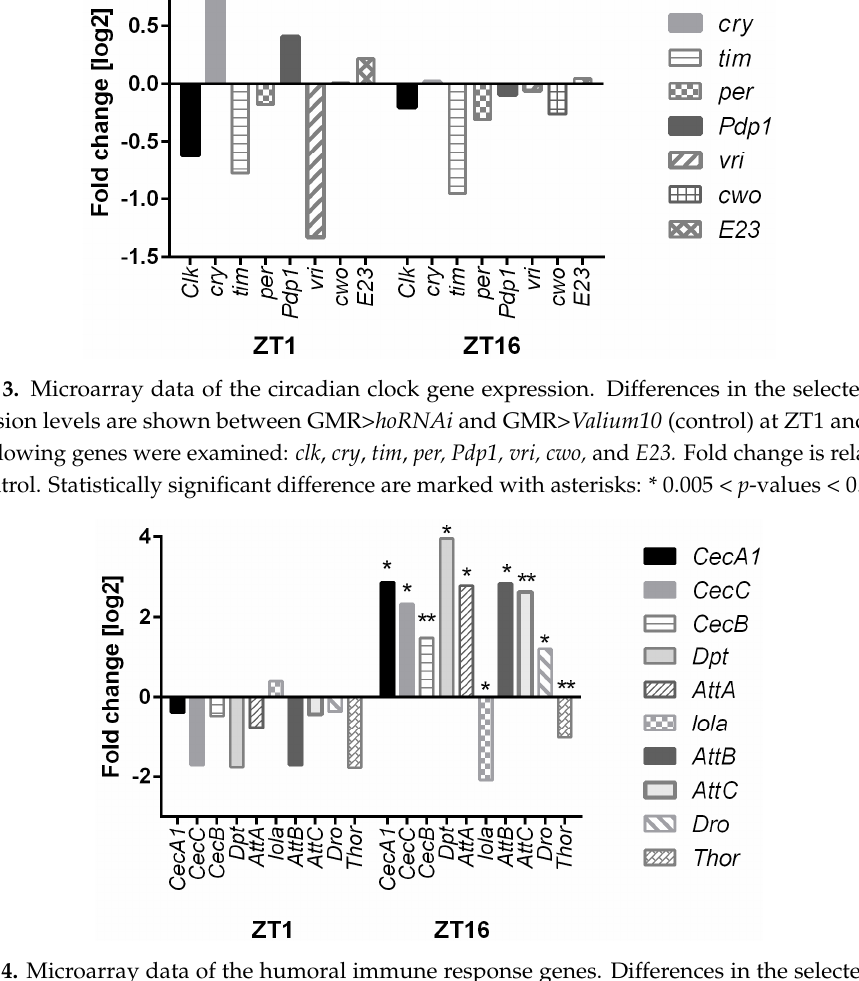
Figure 4. Microarray data of the humoral immune response genes. Differences in the selected gene expression levels are shown between GMR> hoRNAi and GMR> Valium10 (control) at ZT1 and ZT16. Fold change is relative to the control. Statistically significant differences are marked with asterisks: * 0.005 < p -values < 0.05, ** 0.0005 < p -values < 0.005. The following genes were examined: CecA1, CecC, CecB, Dpt, AttaA, lola, AttB, AttC, Dro, and Thor.